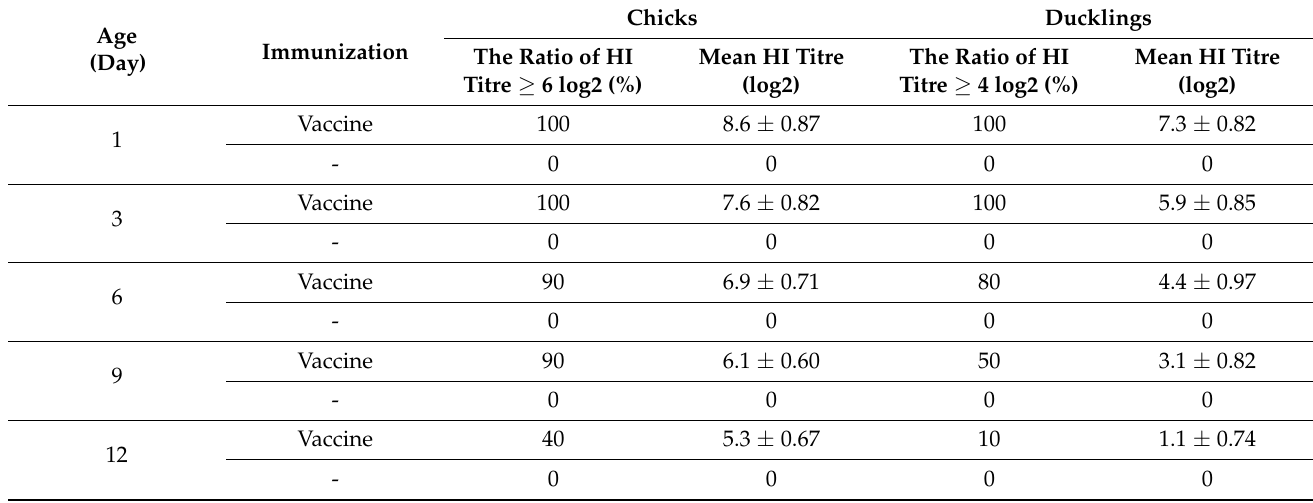
Table 7. The dynamics of maternal antibody in the